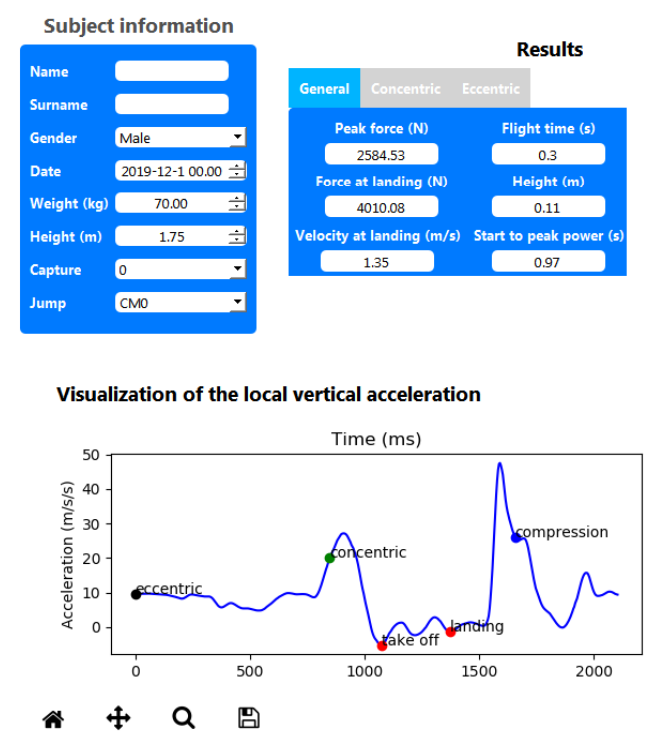
Figure 13. View of a processed jump showing the jumping metrics and the accelerometer graph.